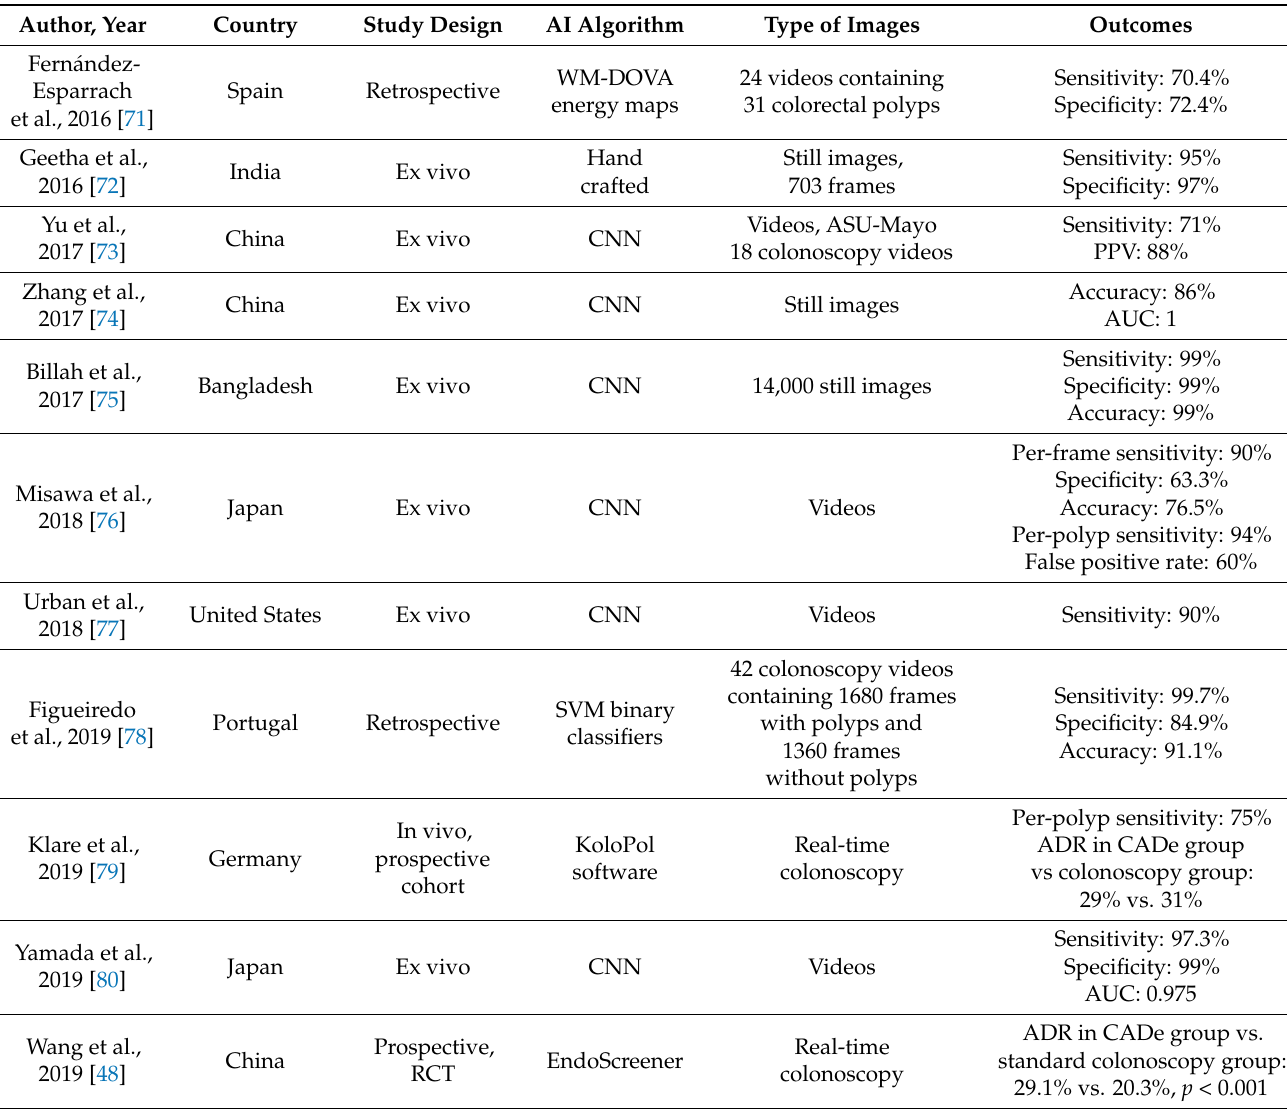
Table 1. Summary of recent studies on AI systems for colorectal polyp